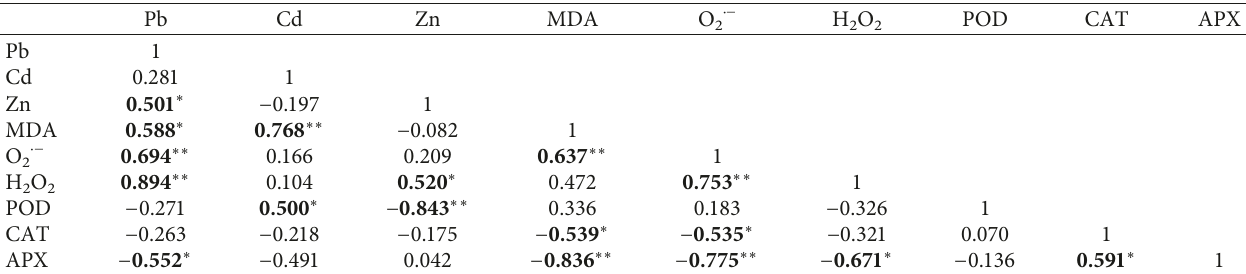
Table 7: Pearson correlation matrix among heavy metal concentrations, oxidative damages, and enzymatic activities in